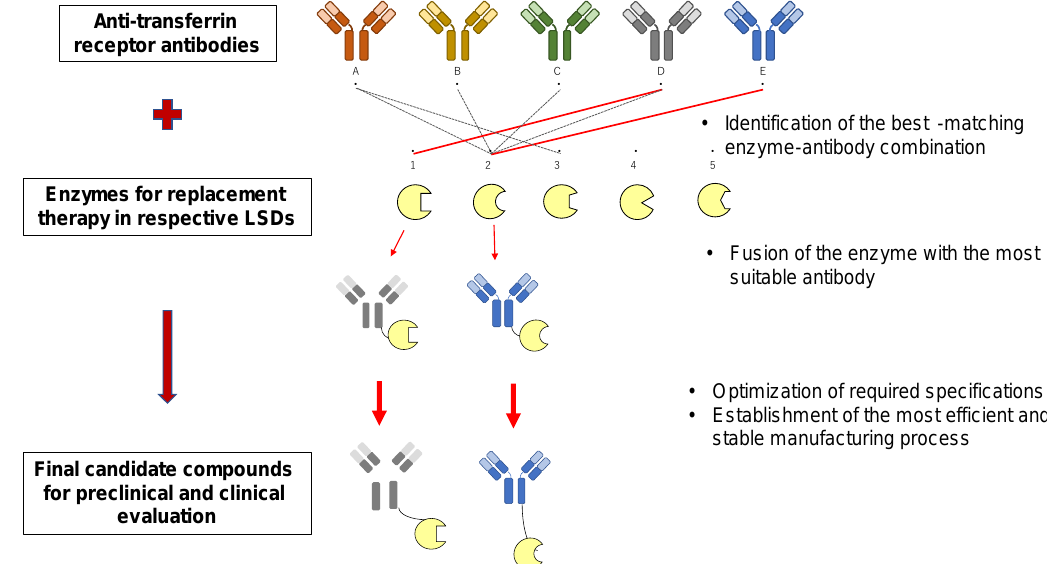
Figure 2. Schematic flow of optimization process of biotherapeutic for RMT-applied ERT .